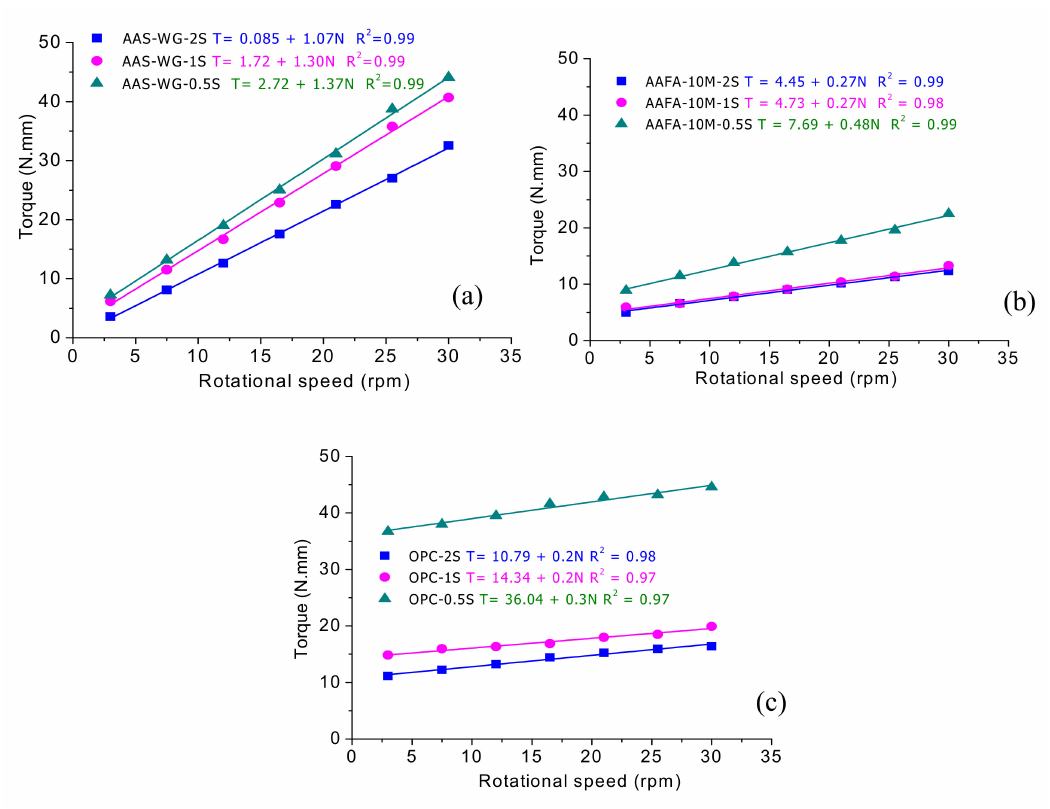
Figure 2. Flow curves for: ( a ) AAS-WG, ( b ) AAFA-10M, and ( c ) OPC with di ff erent particle size of siliceous, aggregate ( D max = 2 mm (2S), D max 1 mm (1S), and D max 0.5 mm